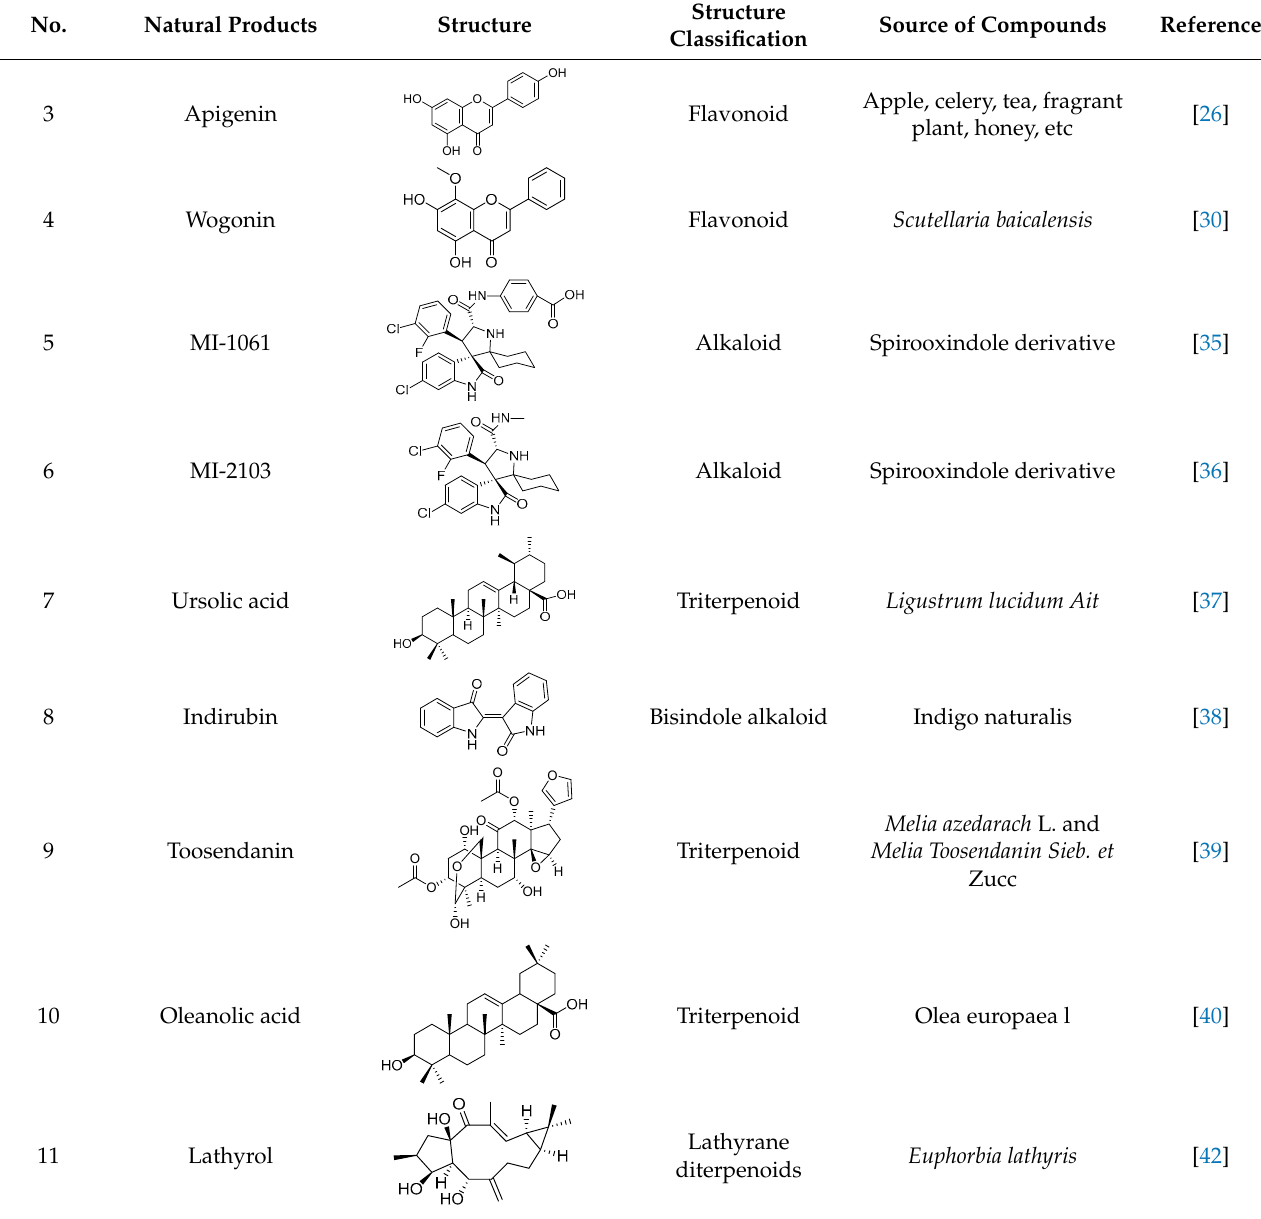
Table 3. Natural products 3–11.